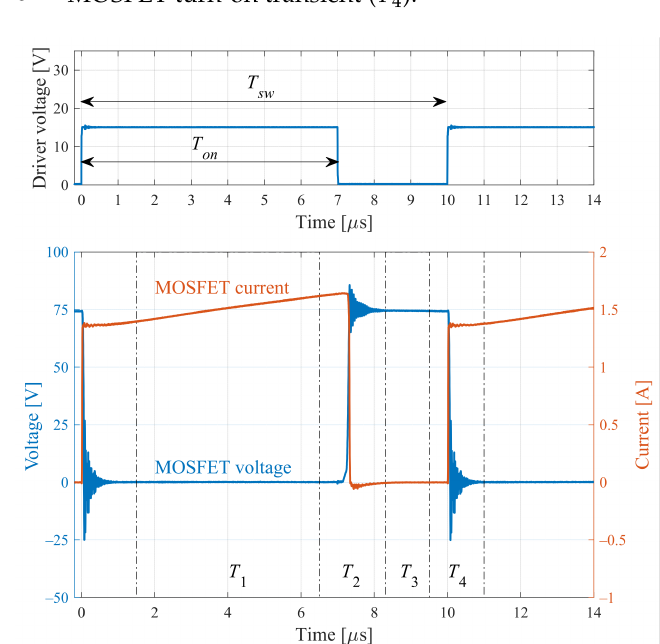
Figure 9. Acquired MOSFET voltage and current